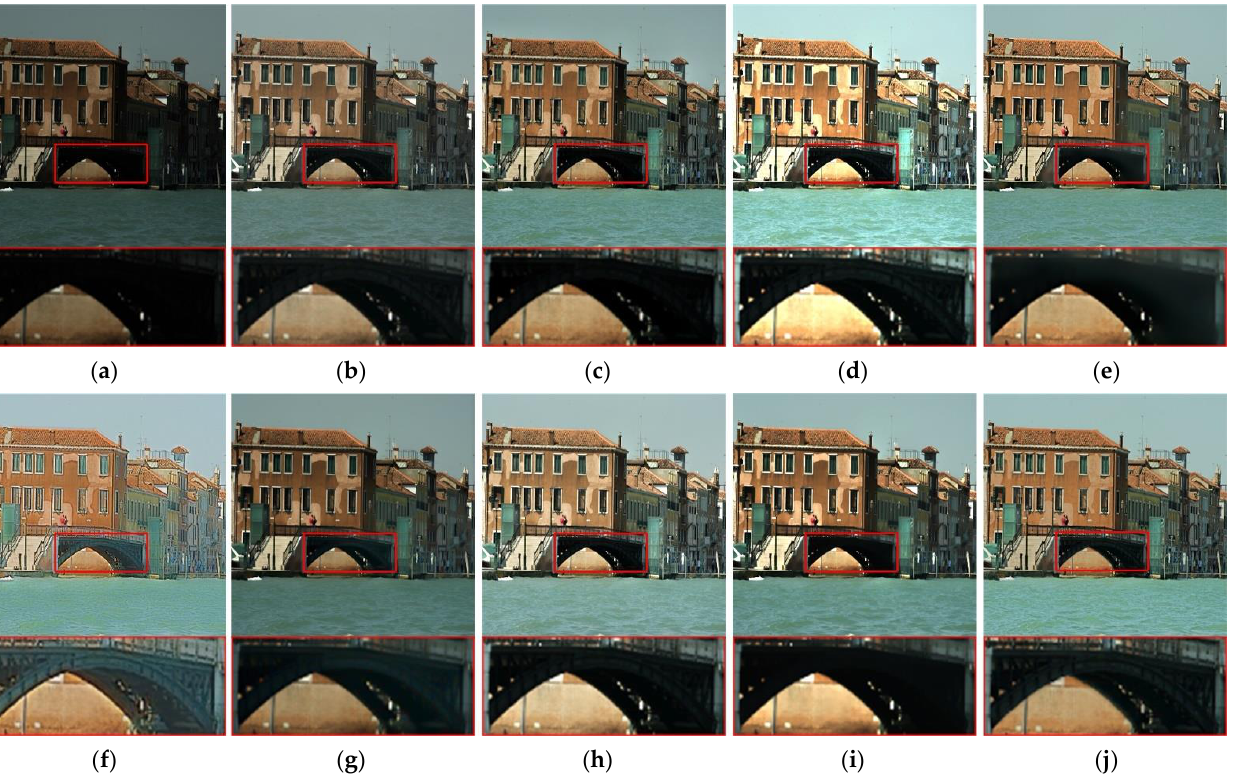
Figure 10. Enhanced results of “Bridge” image. ( a ) Original image; ( b ) BIMEF; ( c ) MEF; ( d ) LIME;